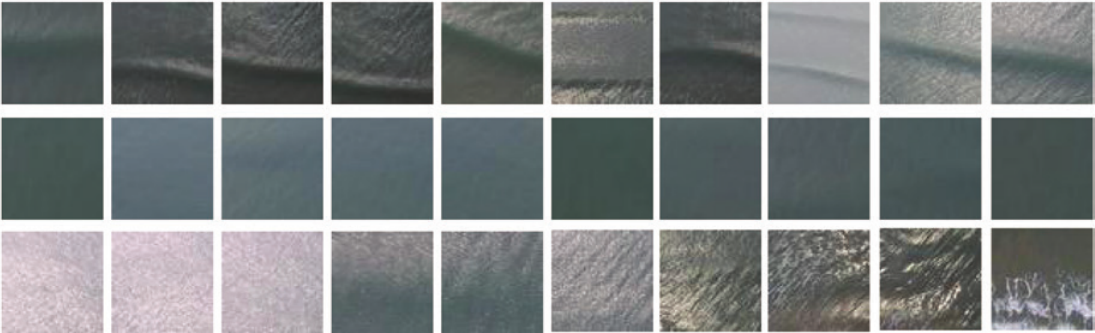
Figure 8: Image patches of three types of inshore surge waves. First row represents positive samples, second row represents the negative samples and third row represents the noises.